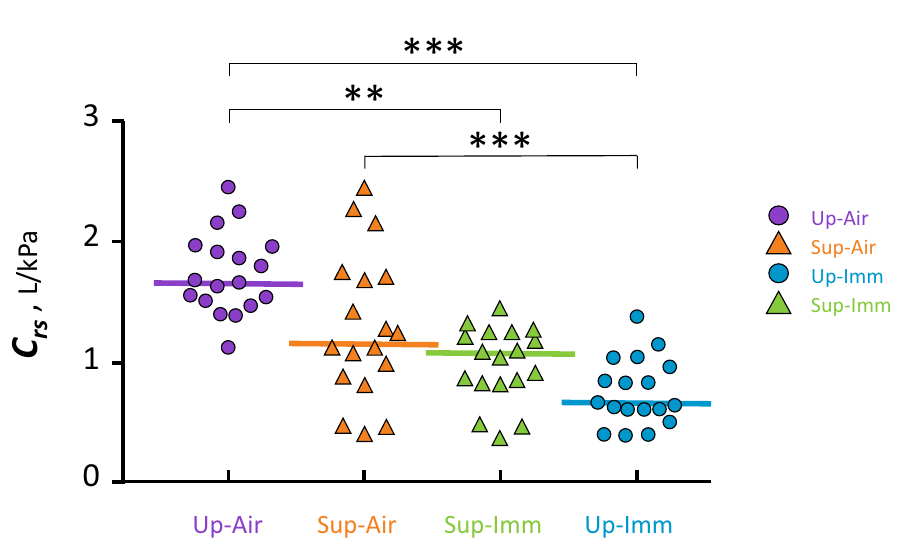
Figure 3. Overall respiratory compliance values ( C rs ) in the four conditions. The thick lines correspond to median values for the group. Symbols are the same as in Fig. 2b. In most subjects, C rs decreased substantially between Up-Air and immersed conditions. Statistical analysis used Friedman’s test, and Dunn’s post-hoc tests. **p < 0.01; ***p < 0.001.